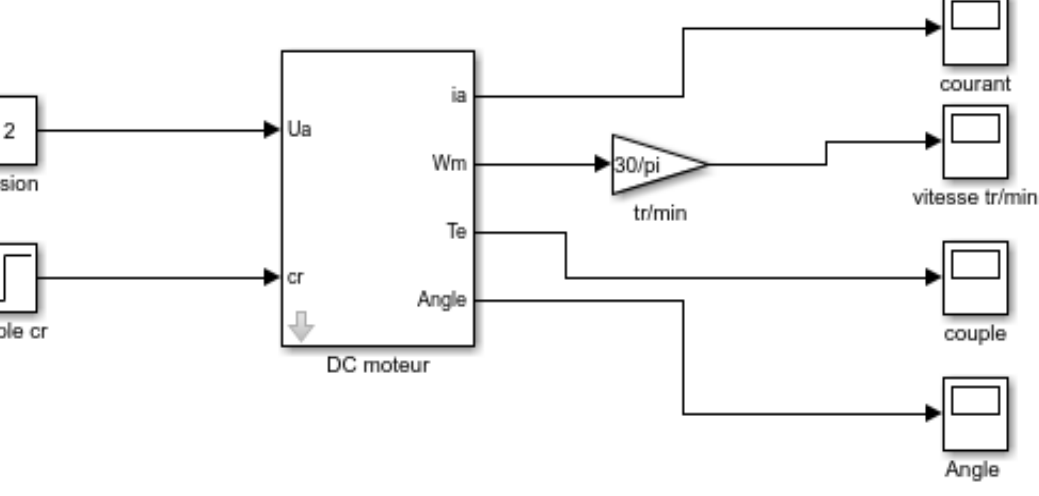
Figure 8. Simulink block model of the servomotor.